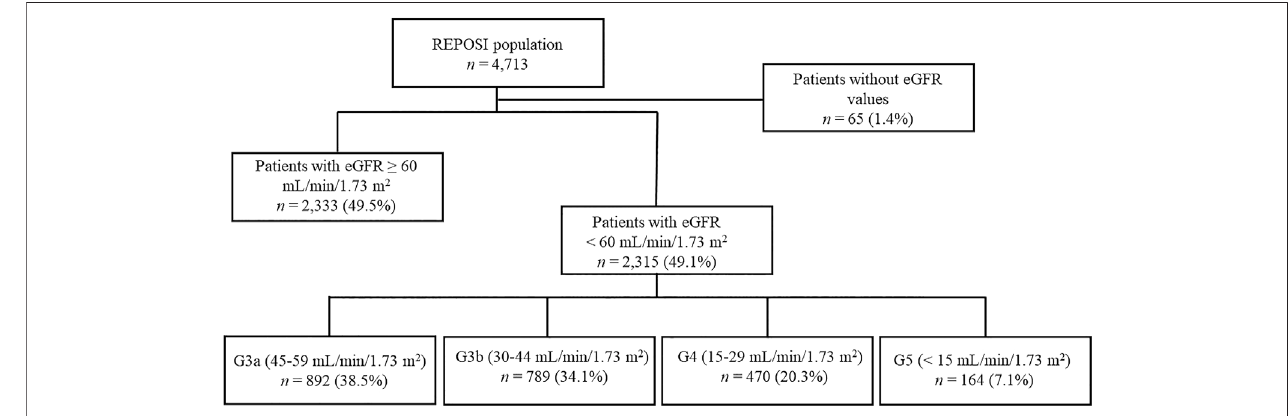
FIGURE 1 | The fl ow chart describes the patients reported into the REPOSI database according to the eGFR values.